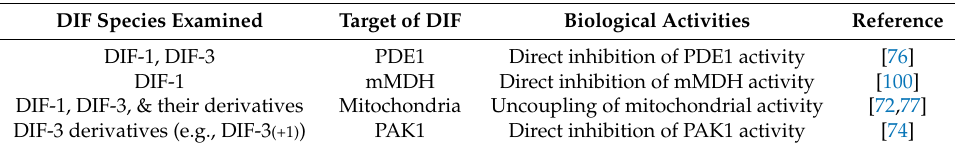
Figure 9. Summary of the physiological functions of DIFs 1 and 2 in Dictyostelium discoideum and the biological activities of DIF derivatives in other organisms. DIFs 1 and 2 function as inducers of stalk-cell differentiation (autophagic cell death: ACD) and as modulators of chemotactic cell movement in D. discoideum (purple rectangles). DIF derivatives have various biological activities in mammalian cells (yellow, orange and green ellipses) and in Xenopus oocytes and Trypanosoma cruzi (pale yellow rectangles). Table 1. Targets of DIFs found in mammalian cells.